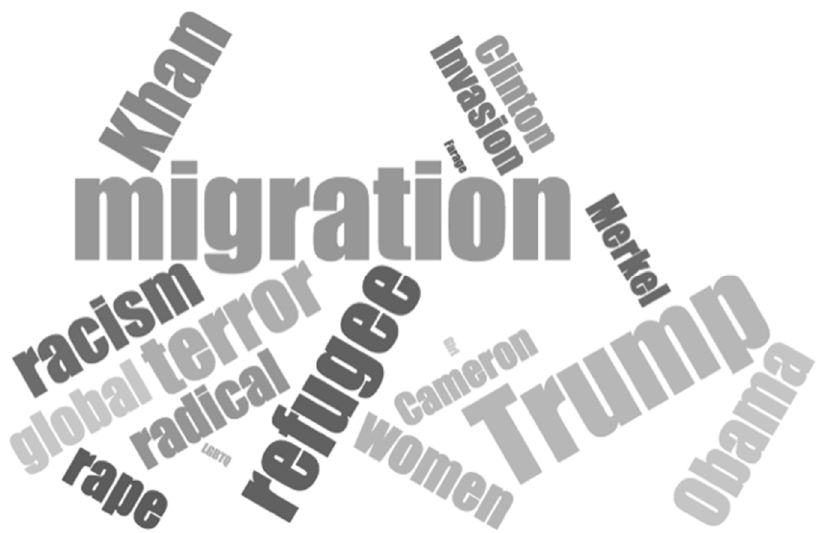
Figure 2. Most-frequently used terms in the dataset of tweets.